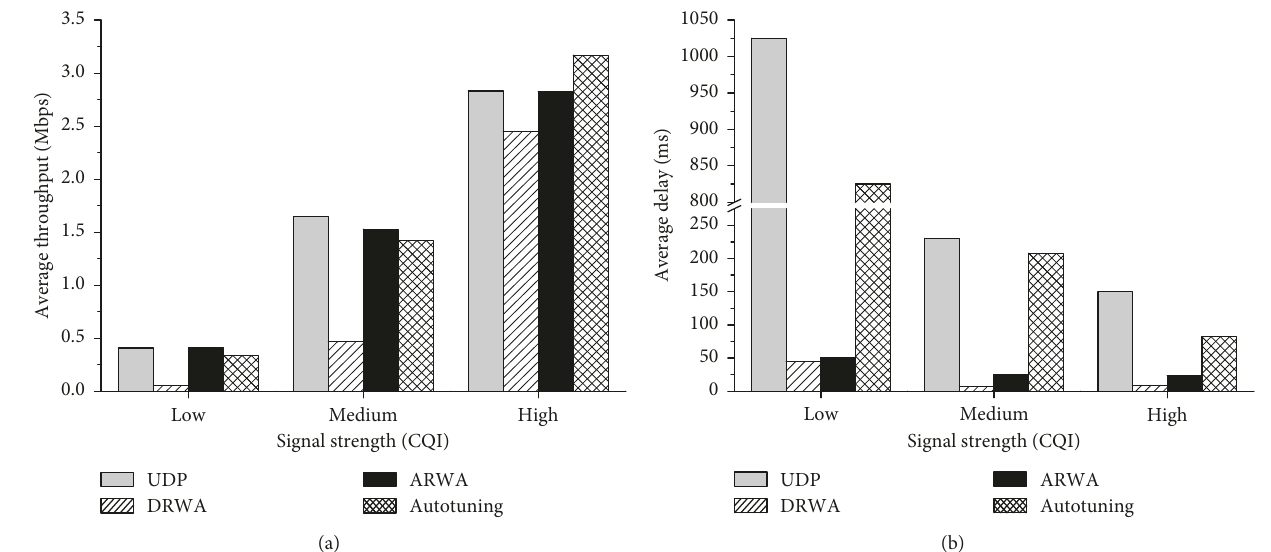
Figure 7: Performance comparison of different flow methods for various signal strengths in LTE network. (a) Average throughput. (b) Average delay.